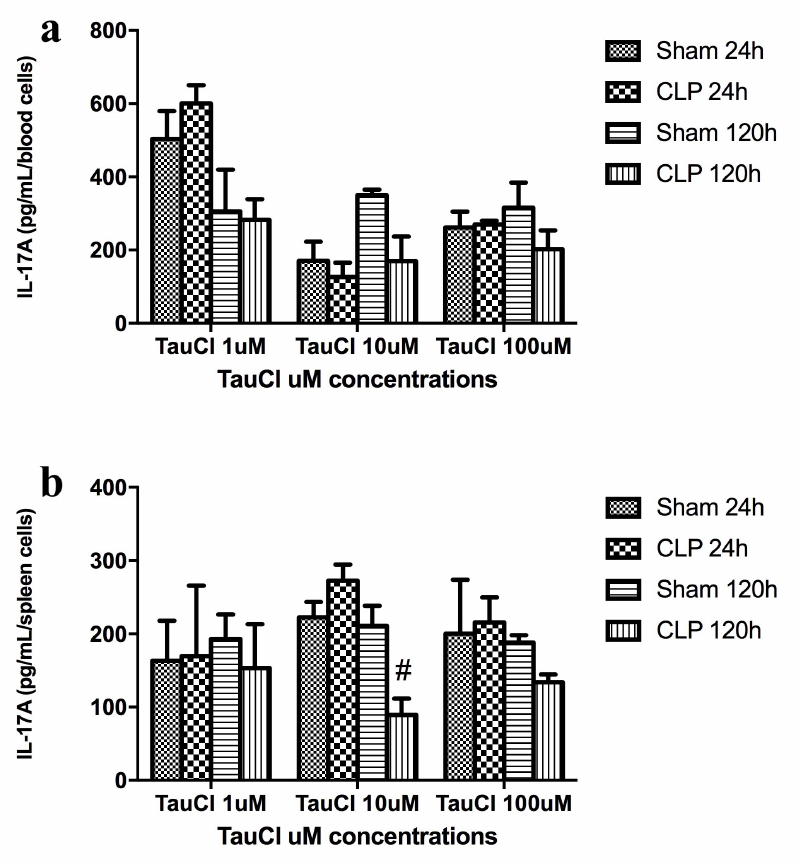
Figure 2. The effect of TauCl on the production of the pro- inflammatory mediator, IL-17A. Lymphocytes (1x106 cells/mL) were preincubated with TauCl (1, 10 or 100 uM) for 1 hour. After this, supernatants were collected and IL-17A was measured by ELISA for (a) blood and (b) spleen. Results are expressed as means ± SD. # = P < 0.05, compared with sham rats at 120 hours